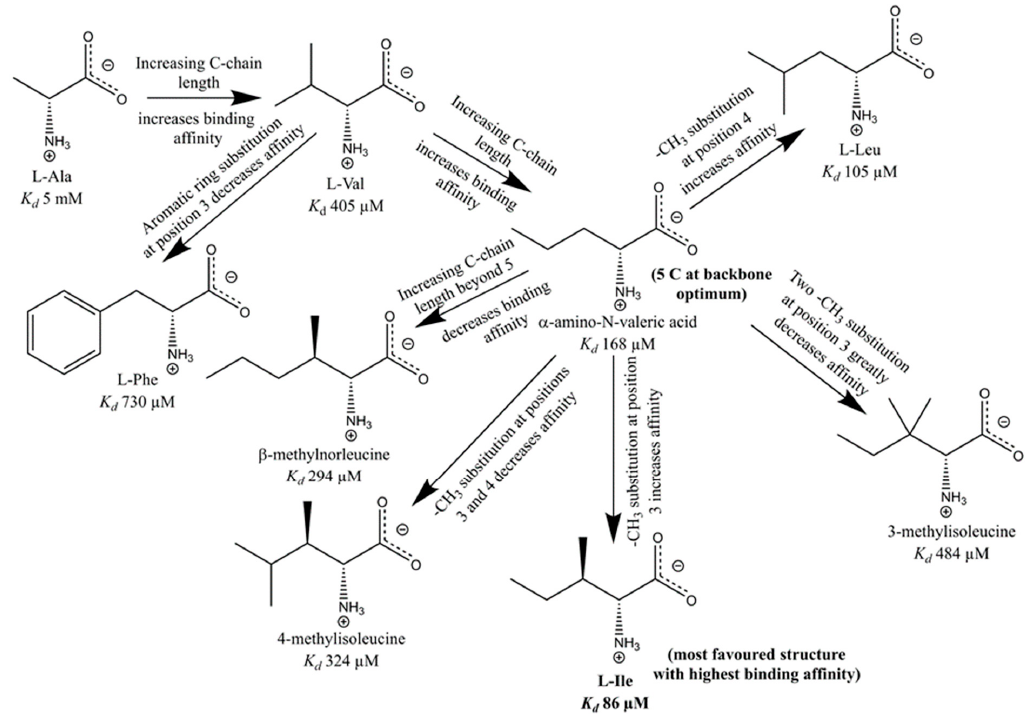
Figure 10. Structure–activity relationship of hydrophobic amino acids as chemoreceptor Tlp3 ligands.